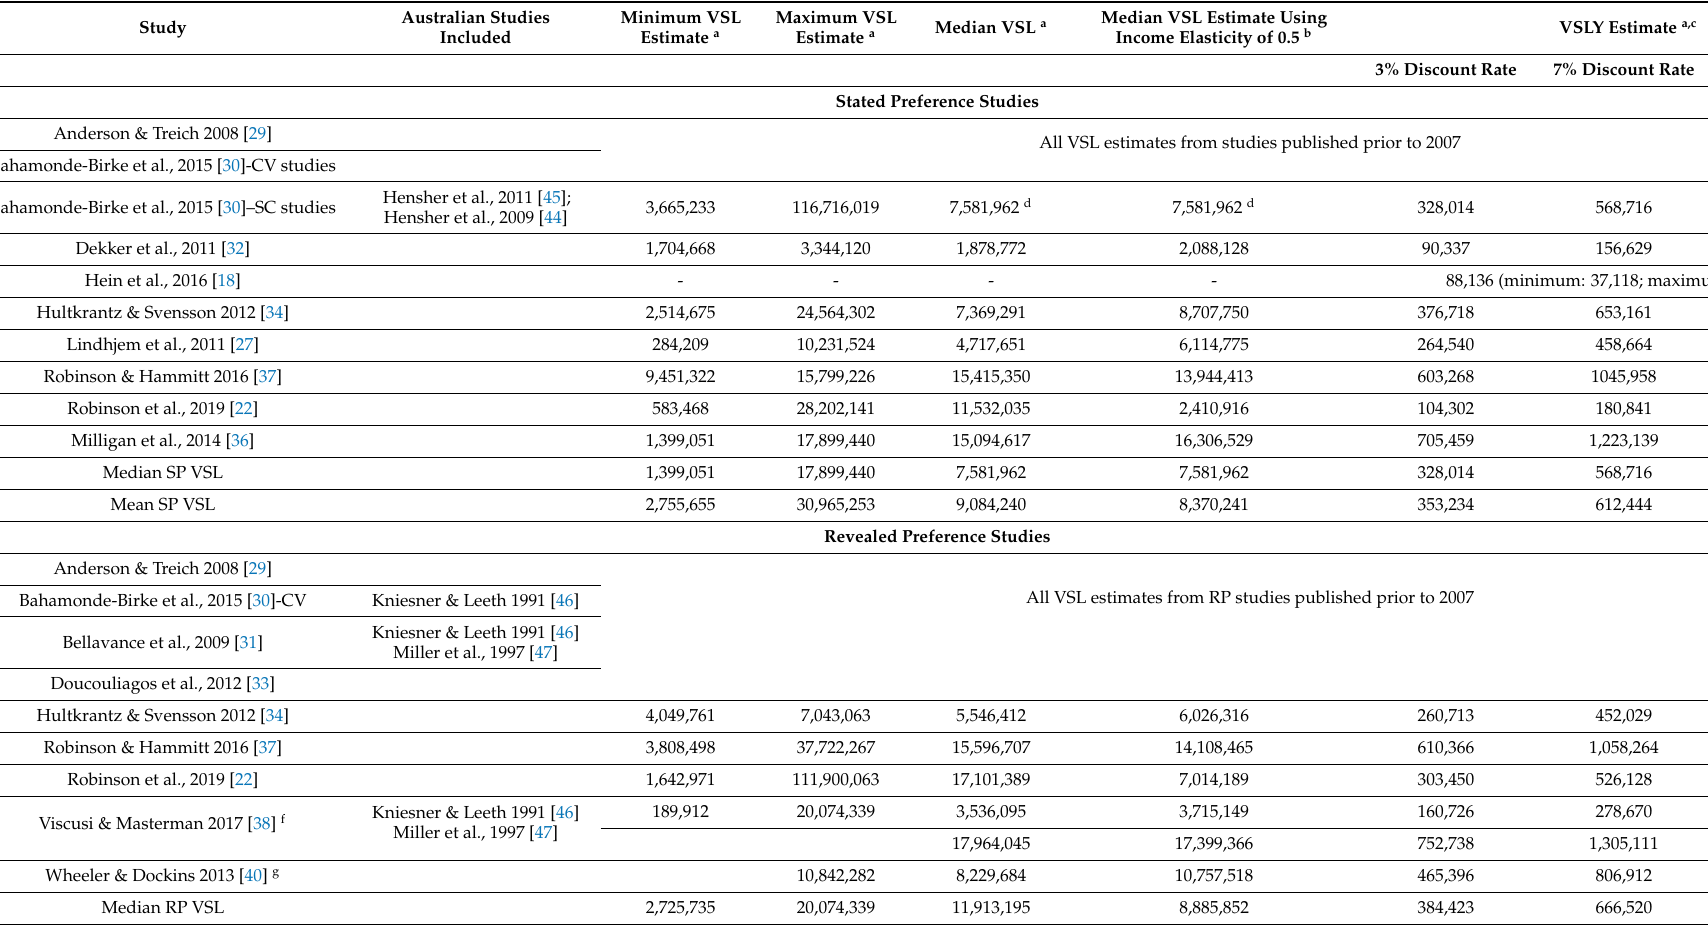
Table 2. VSL values from review papers